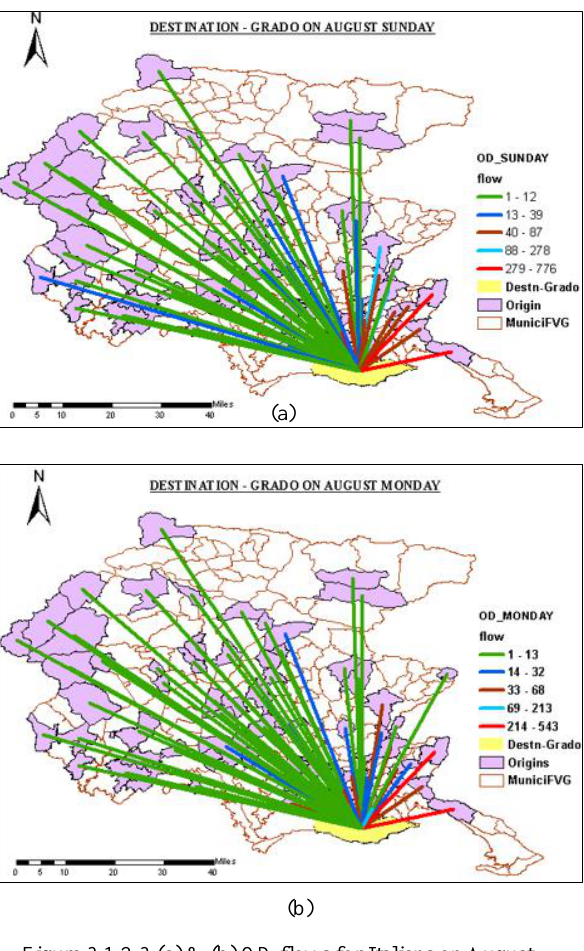
Figure 3.1.2-3 (a) & (b) OD flows for Italians on August Sunday and Monday Fig 3 . 1.2-3 a & b shown explains the following points.  Flow count represents number of times to and fro movement happening. The flows of Italians from Sunday to Monday are 776 to 543.  The flow of Italians to Grado are decreasing from Sunday to Monday. Flow from 1 to 30 are from more places of west Friuli region and flow count is less due to distance from origin to destination is farther.